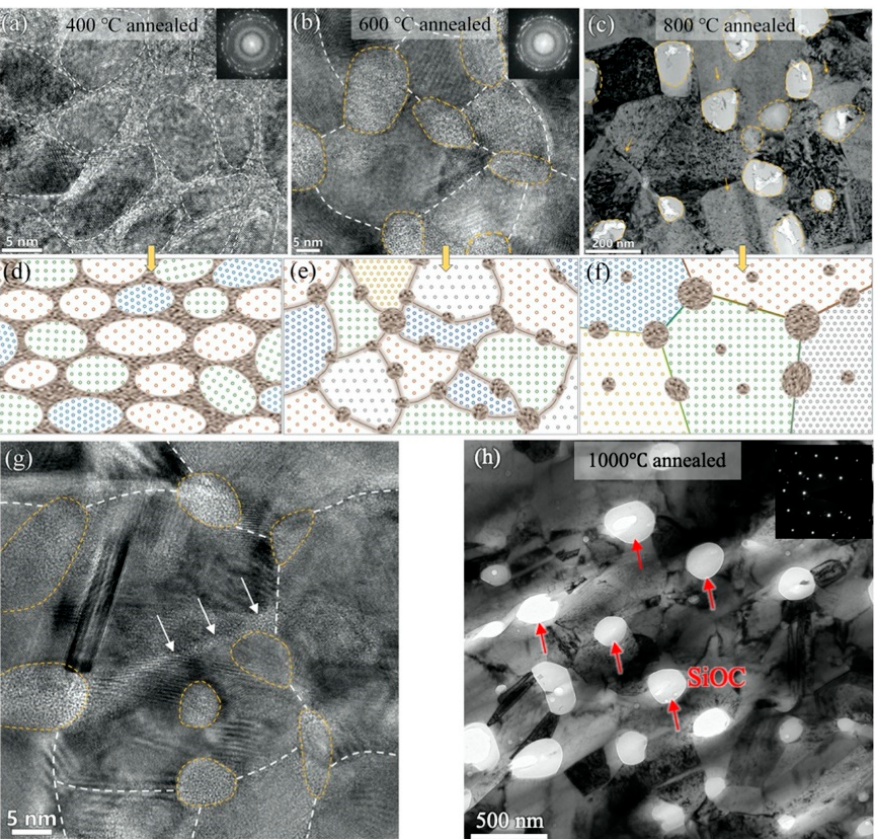
Figure 8. TEM images of Ni(75 at.%)-SiOC nanocomposites after the as-deposited sample was annealed at ( a ) 400 °C, ( b ) 600 °C and ( c ) 800 °C for 1 h [60]. ( d – f ) Schematics of characteristic microstructures corresponding to ( a – c ). ( g ) A HRTEM image of the 600 °C annealed nanocomposite showing amorphous GBs. ( h ) A TEM image of 1000 °C annealed Ni(75 at.%)-SiOC nanocomposite. The white arrows indicate amorphous Gbs, and the red arrows indicate amorphous particles.